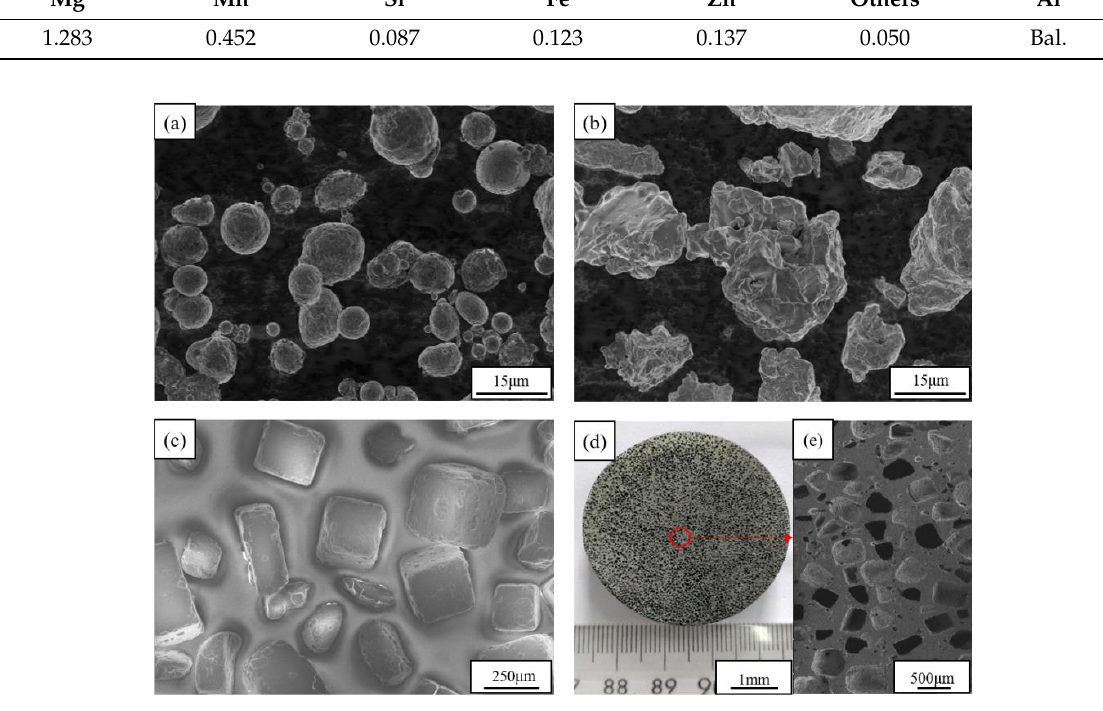
Figure 1. ( a – c ) SEM images of the raw powders: ( a ) 2024Al, ( b ) Zr, ( c ) NaCl. ( d , e ) the sample surface morphology of the sample. morphology of the